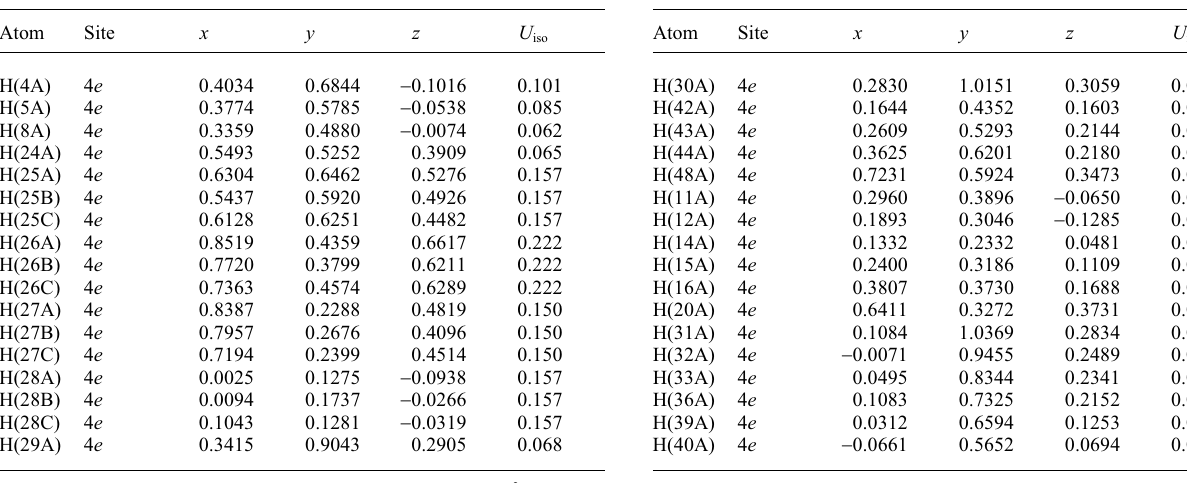
Table 3. Atomic coordinates and displacement parameters (in Å 2 )